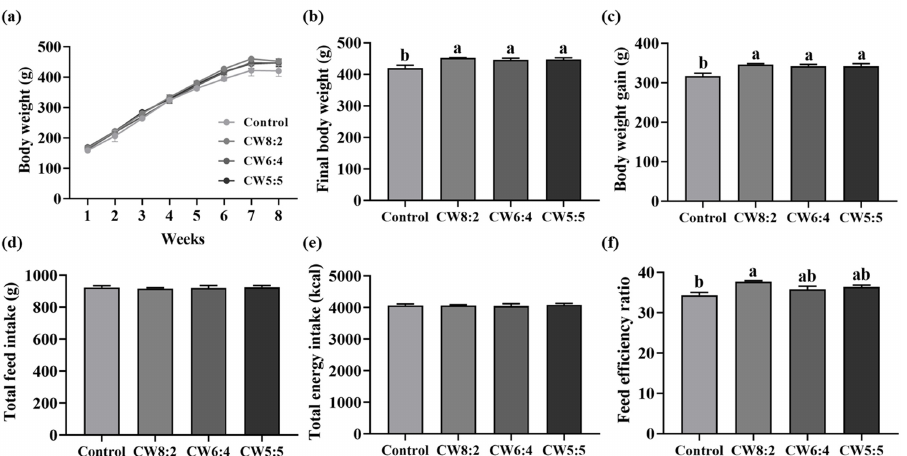
Figure 1. The growth performance of rats administered milk with adjusted casein to whey proteins ratio for eight weeks ( n = 6): ( a ) weekly body weight (g), ( b ) final body weight, ( c ) body weight gain (g), ( d ) total food intake (g), ( e ) total energy intake (kcal), and ( f ) feed efficiency ratio. Data are expressed as mean ± SEM. The values with different letters indicate significant differences at p < 0.05. CW, casein:whey proteins.